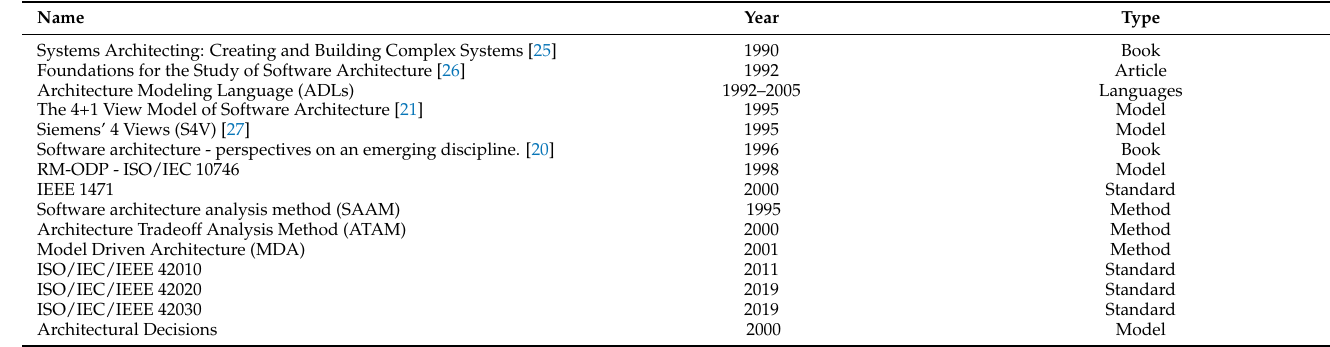
Table 1. Seminal works related to software architecture, from the first years of the 1990s up to 2020.